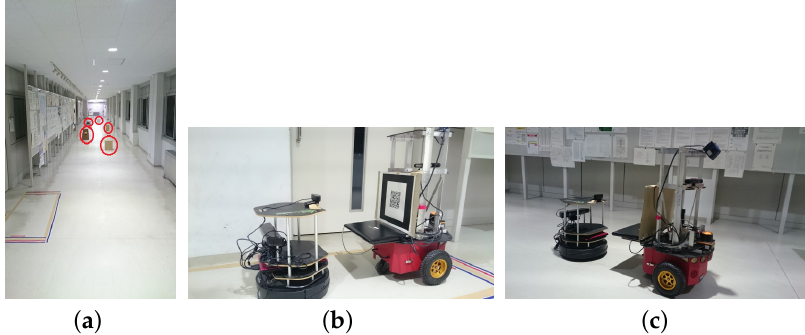
Figure 11. Experiment 2. ( a ) Environment with new obstacles marked in red; ( b ) Coupling between the two robots using left wall as marker ( c ) Turtlebot following P3DX through visual servoing. (Refer the accompanied video provided in the Supplementary Materials section).